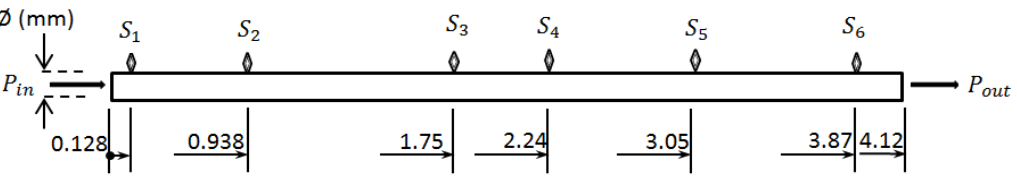
Figure 5. Schematic pipe geometry in 2D.